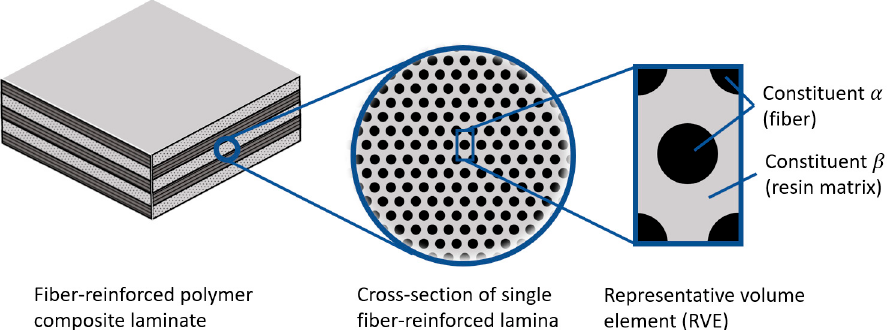
Figure 1. Representative volume element within a fiber-reinforced polymer composite laminate.